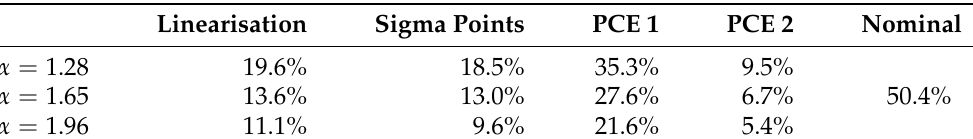
Table 4. Constraint violations obtained from Monte Carlo simulations for the maximising ethanol objective via all the methods and backoff parameter values.